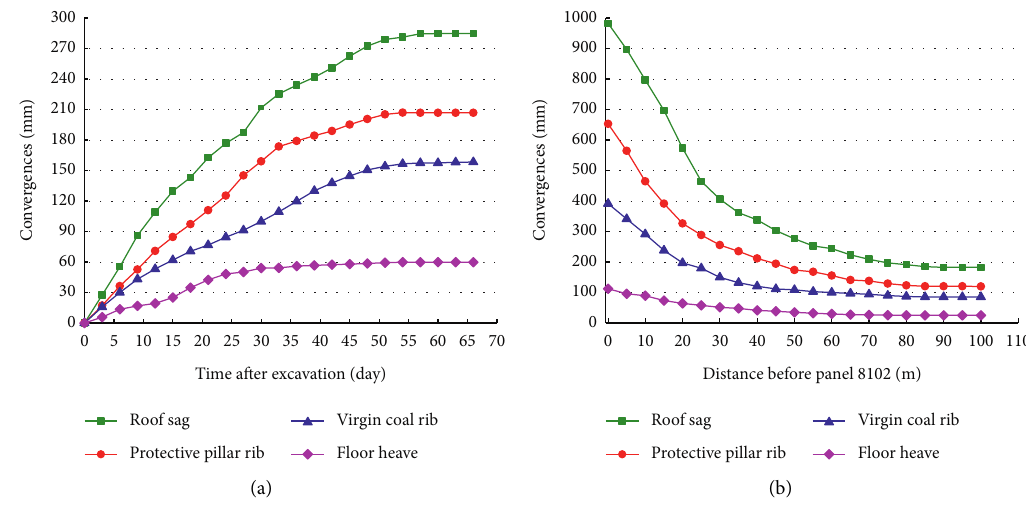
Figure 5: Measured convergences in 8102 headgate. (a) During 8102 headgate excavation. (b) During panel 8102